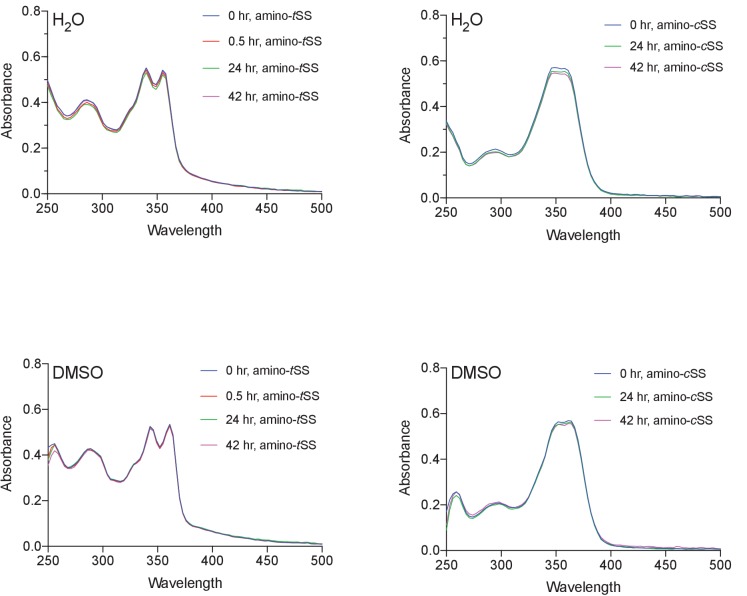
Stability of amino-tSS and amino-cSS in water and DMSO analyzed by UV-vis spectroscopy.Both isoforms of the ligand are relatively stable in either solvent for the indicated times.